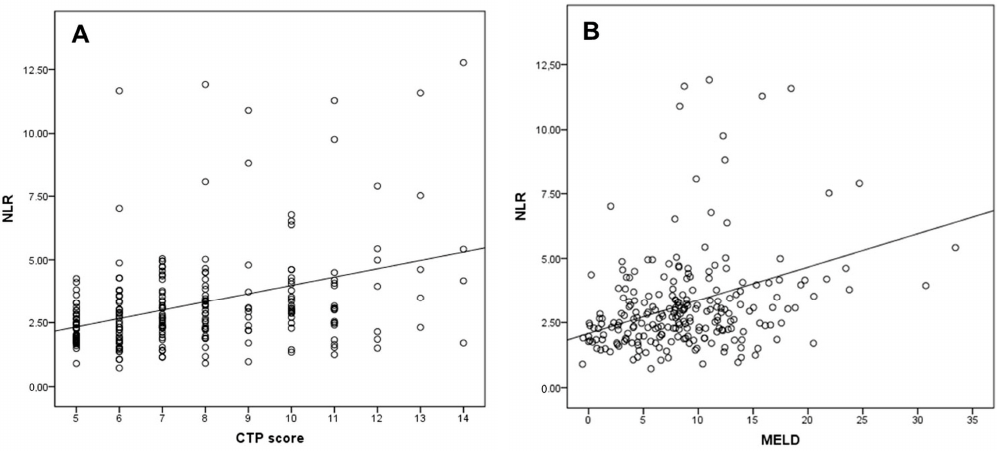
Figure 3. Correlation of the NLR with ( A ) CTP score and ( B ) MELD score.